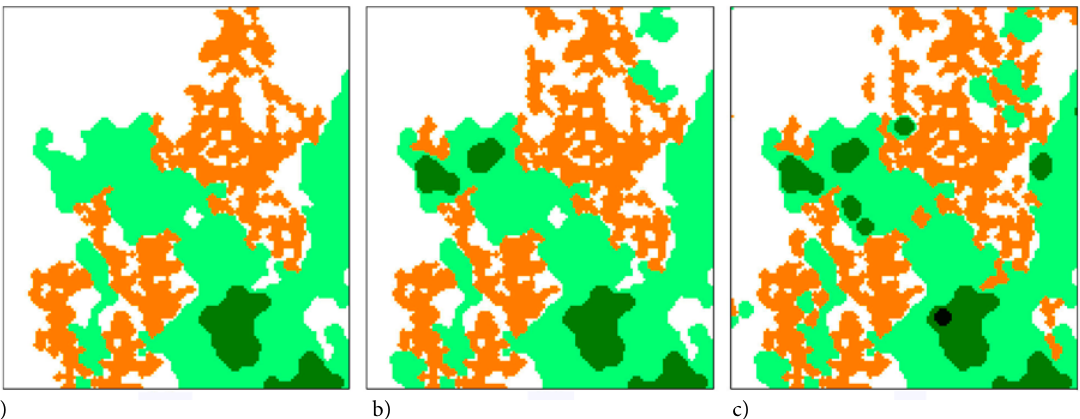
Fig. 8. The effect of reducing the minimum size of half tone areas. (a) Reference result: minimum half tone area is 225 m 2 . (b) Minimum half tone area is reduced to 112.5 m 2 . (c) Minimum half tone area is reduced to 22.5 m